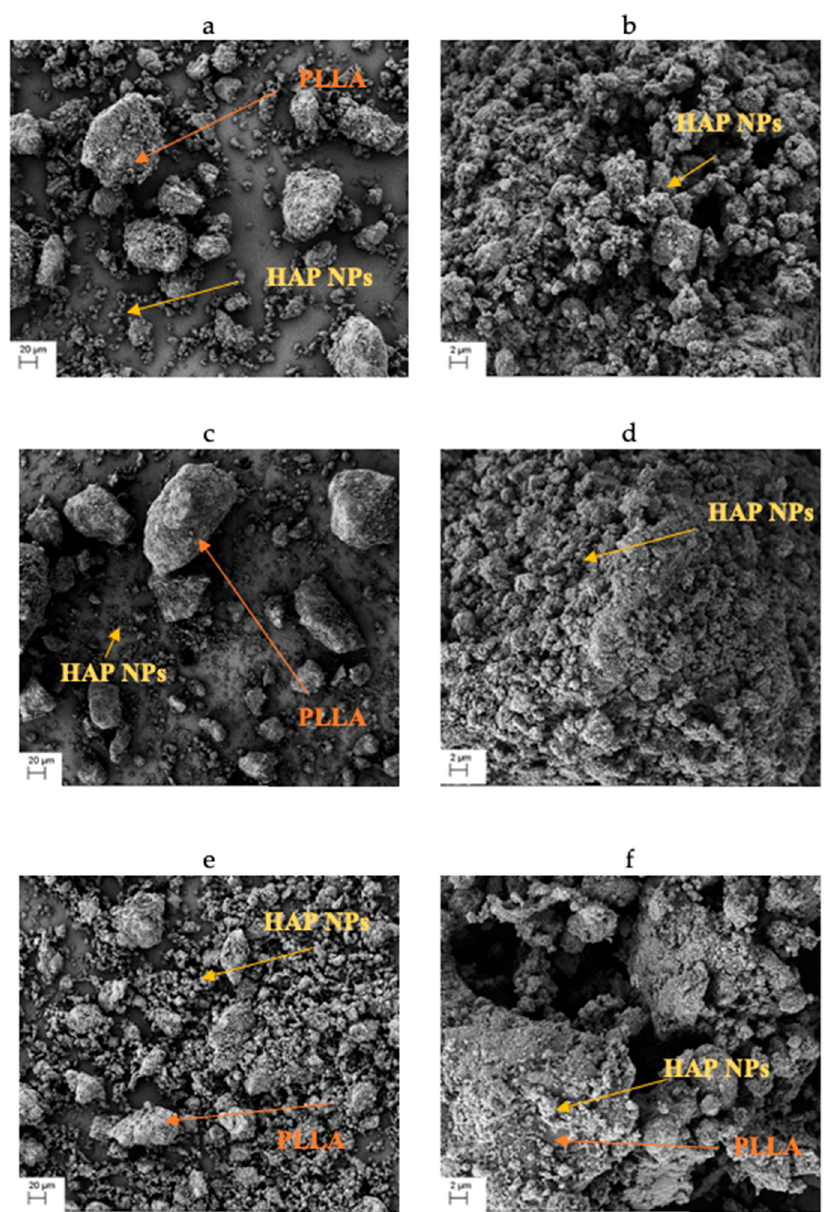
Figure 3. Composite granules for various proportions of HAP NPs, 25com ( a , b ), 50com ( c , d ), 75com ( e , f ).